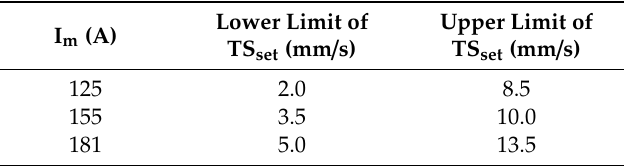
Table 5. Workable TS set range for I min , I mid , and I max